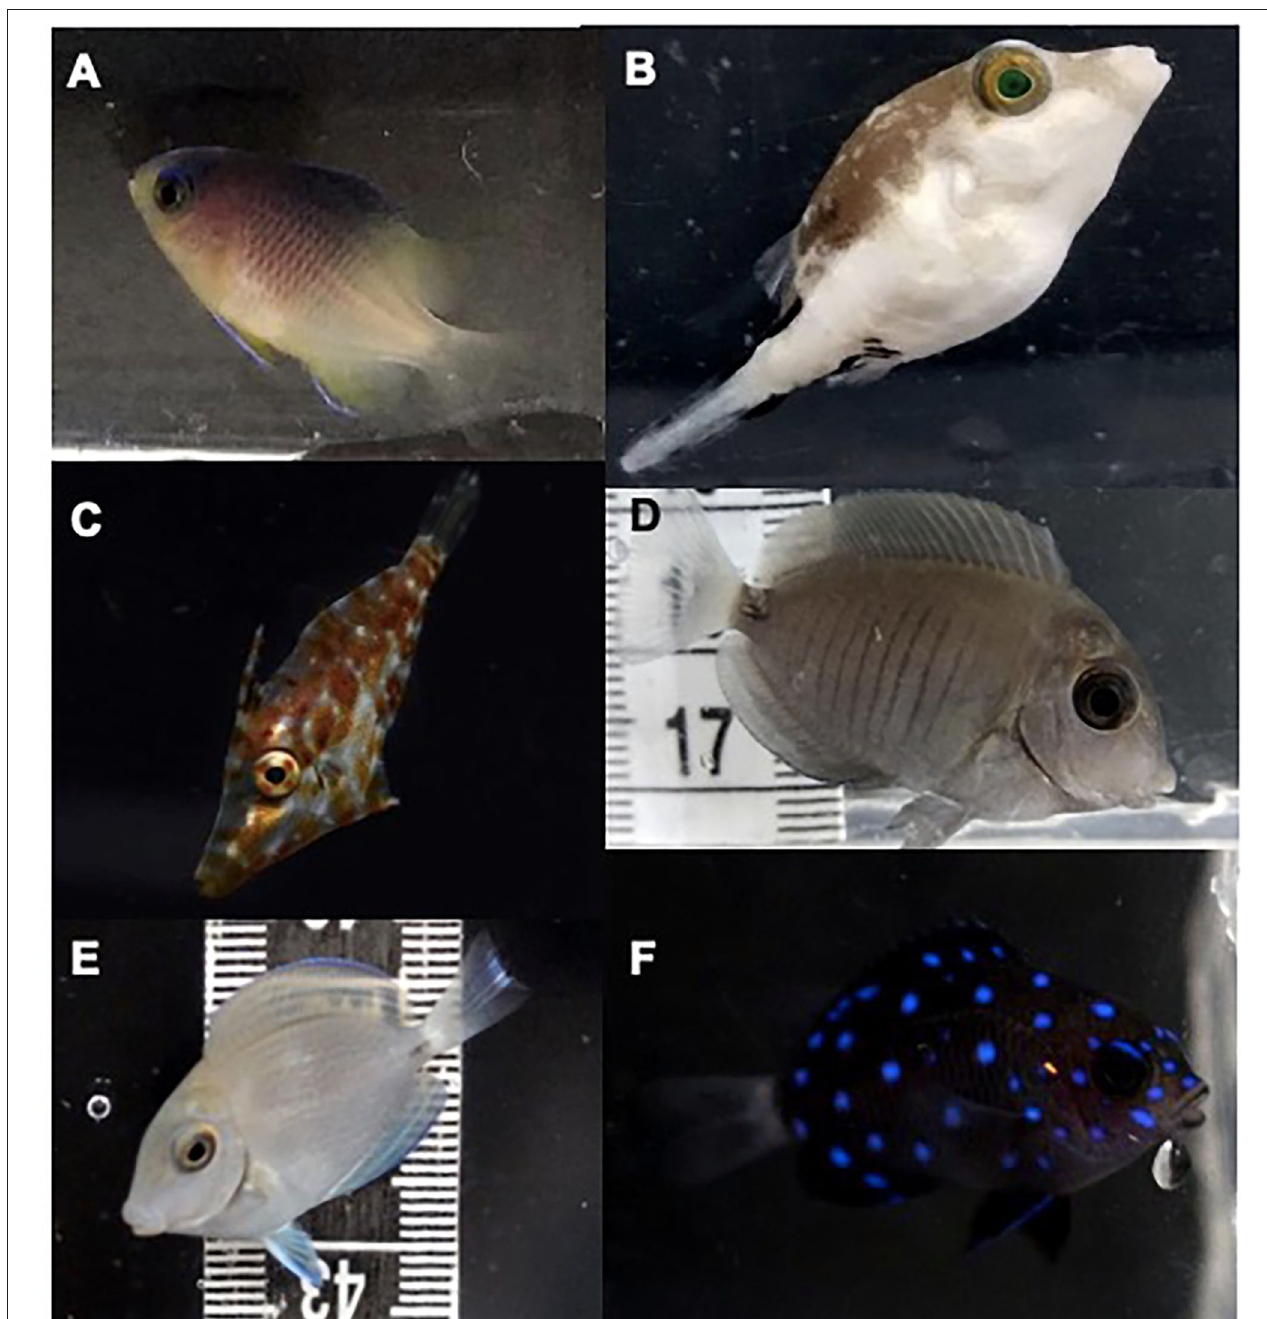
FIGURE 3 | Some of the most abundant species recorded in the area include the following: (A) Stegastes partitus ; (B) Canthigaster rostrata; (C) Monacanthus tuckeri , (D) Acanthurus chirurgus , (E) Acanthurus tractus , and (F) Mycrospathodon chrysurus . survived, while juveniles released after 32 days in culture survived 100% ( n = 21). A significant difference in survival of juveniles released was evident based on results for the two trials ( P = 0.04, X2 =